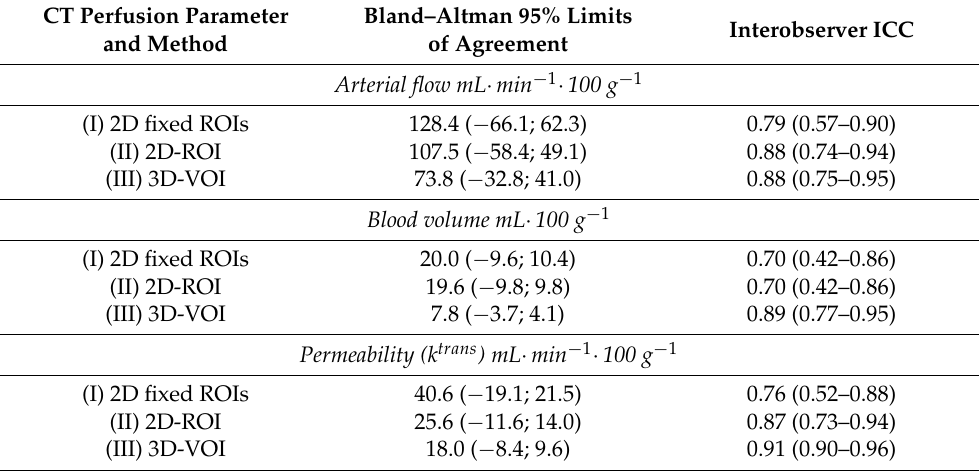
Table 1. Inter-observer reliability between readers.